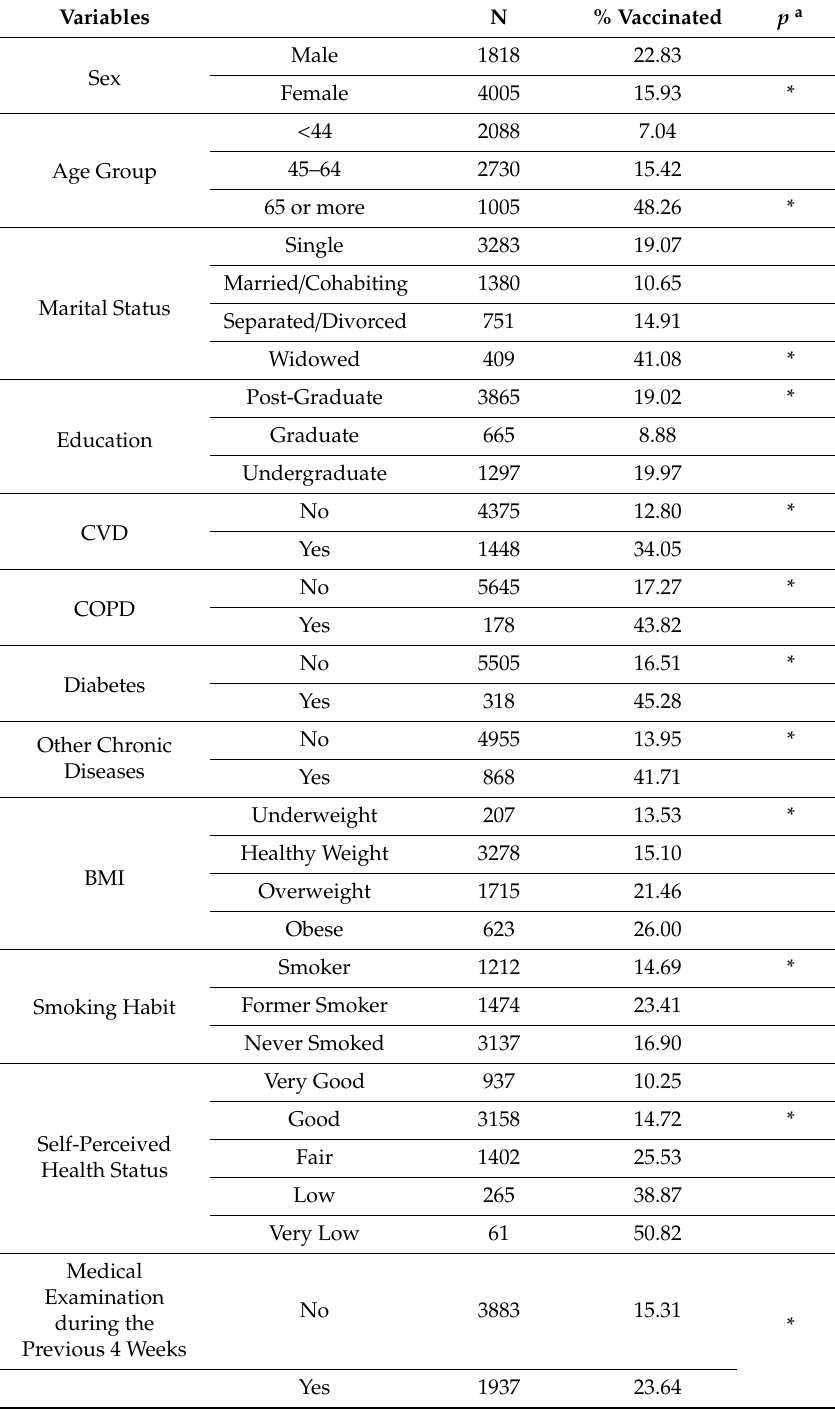
Table 1. Vaccine coverage of healthcare workers and their children during the previous 12 months, distribution of socioeconomic, lifestyle, and health characteristics of